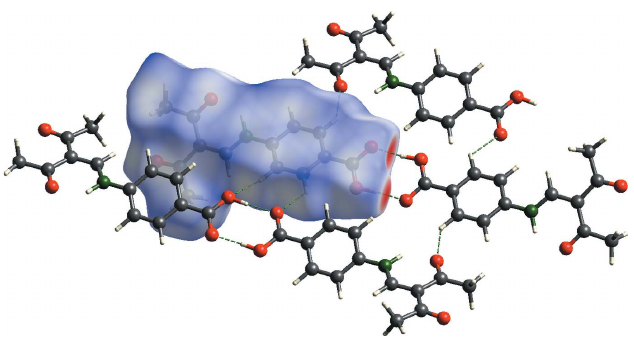
Figure 11 View of the Hirshfeld surface of 3 mapped over d norm in the range (cid:5) 0.761 to 1.366 au showing intermolecular hydrogen bonds as green dashed lines.